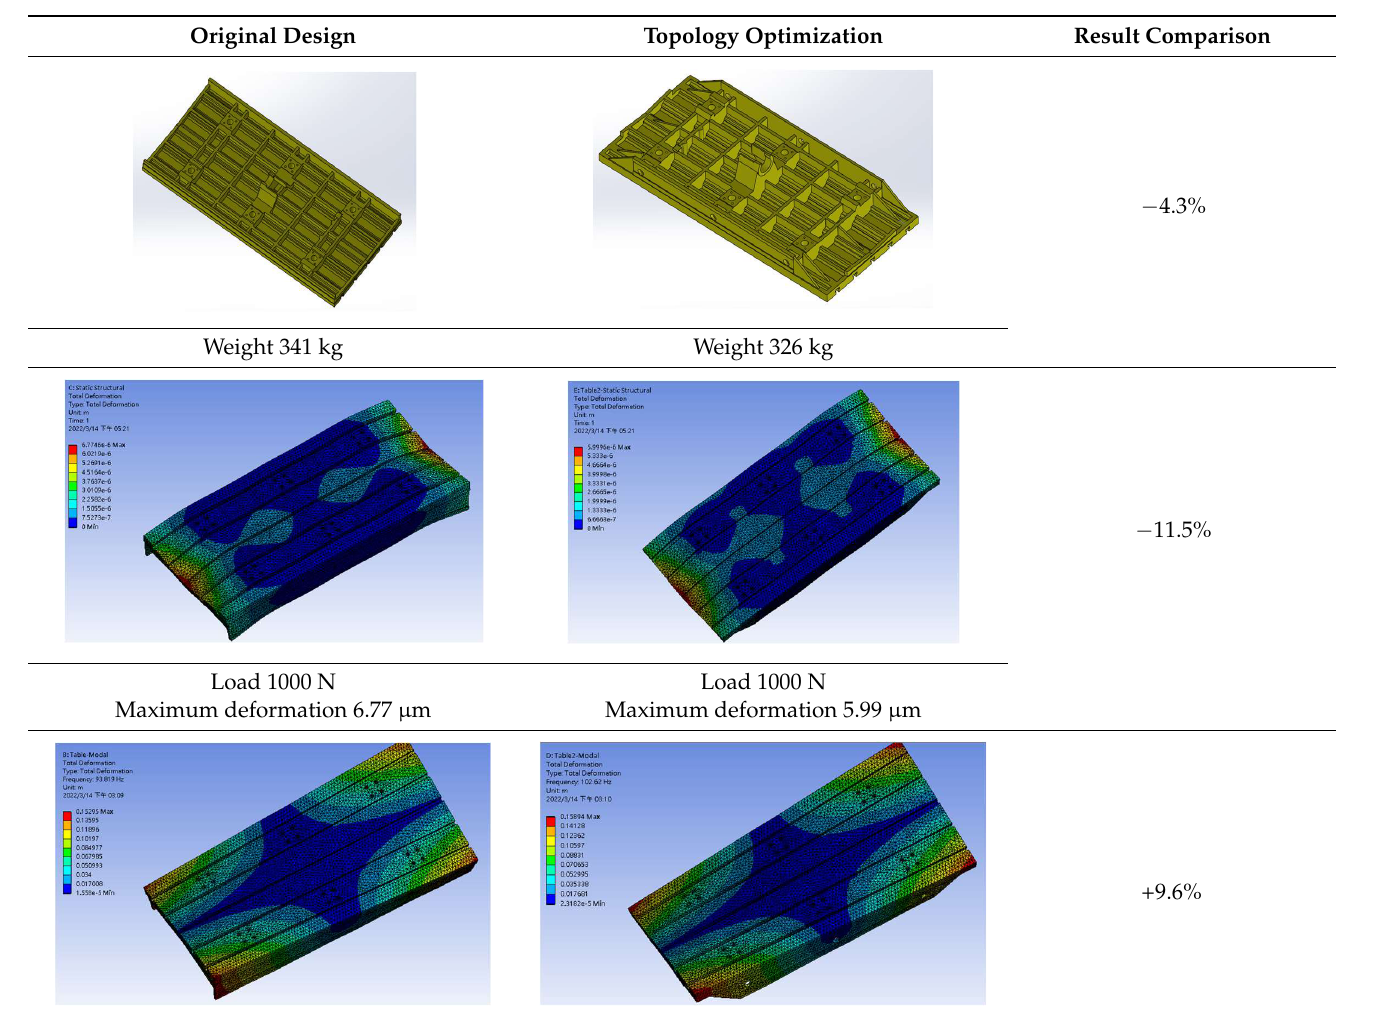
Table 12. Worktable optimization result comparison.